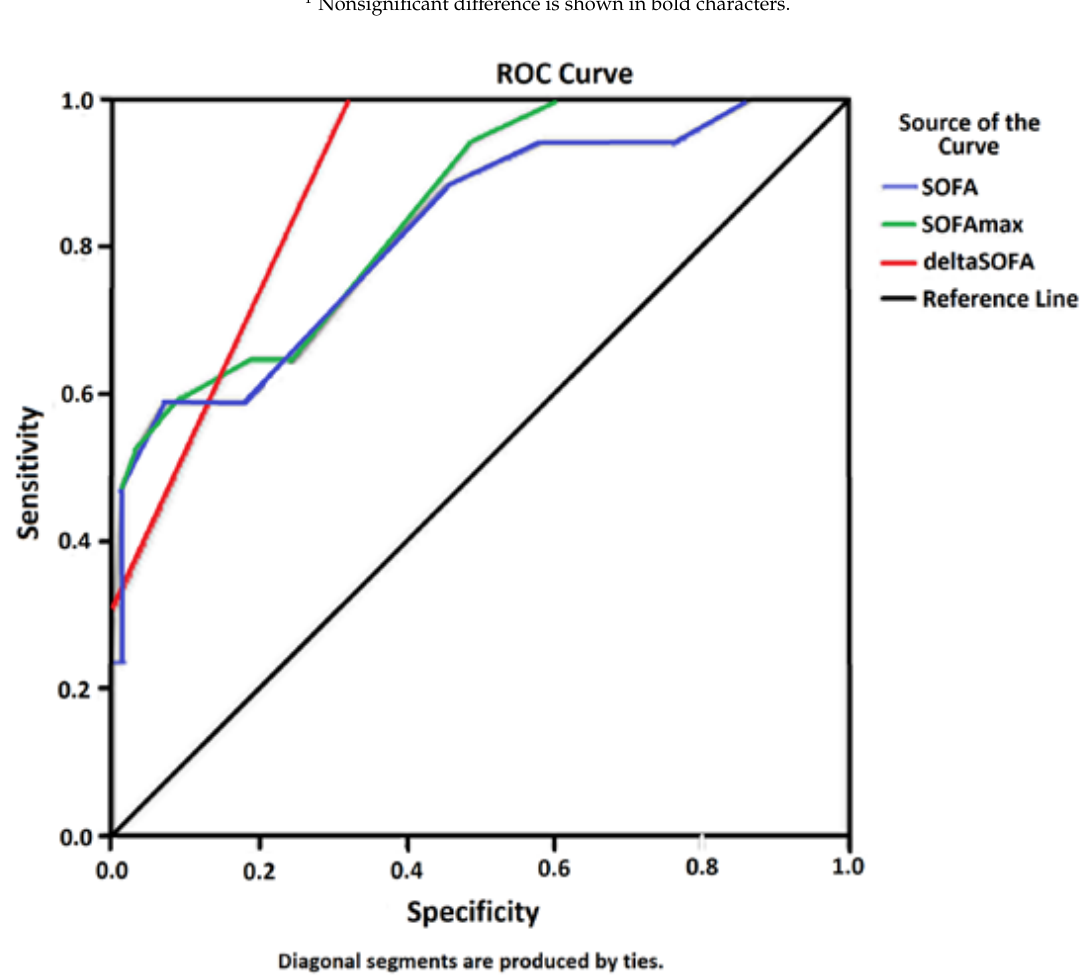
Figure 3. ROC curves for three variants of the SOFA score based on mortality observed in hospitalized patients ( n = 101) with severe malaria.